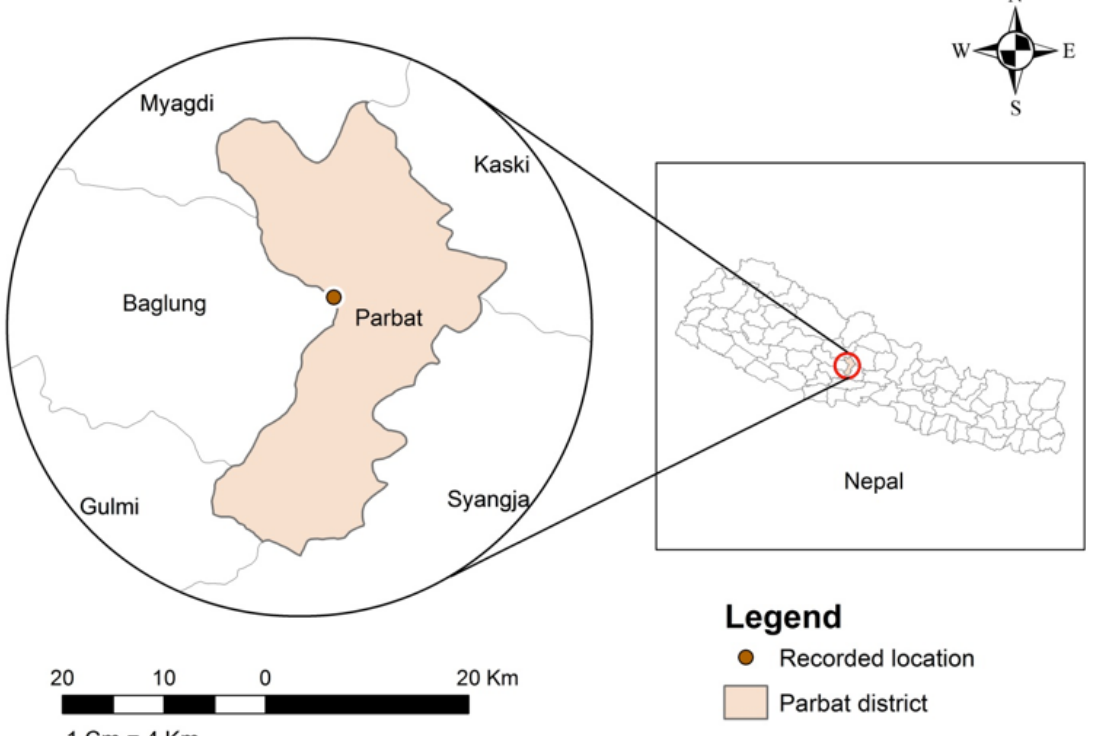
Figure 1. New record of Tylonycteris fulvida near Gupeteshore Cave of Kushma, Parbat, Nepal.